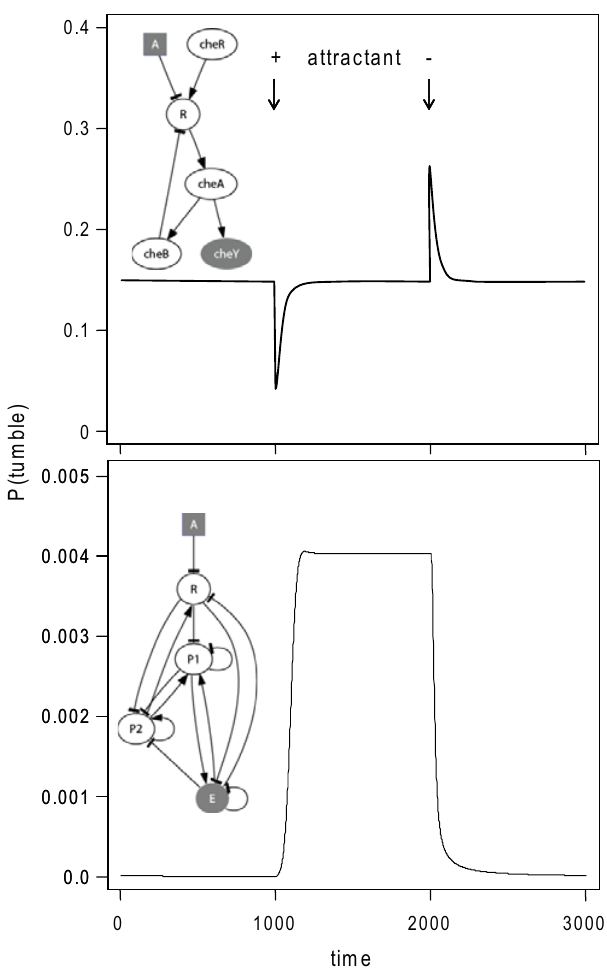
Figure 2. Adaptive versus non-adaptive pathway dynamics. Time course of phosphorylated CheY concentration (top), as simulated by the model presented in [10] and the time course of active effector concentration for the most frequent pathway in the evolutionary simulation described in Figure 1 (bottom). The inset shows the cartoon representation of this pathway. In both simulations, the system is allowed to pre-equilibrate for 1,000 timesteps. A stimulus of one is then added at time 1,000 and removed at time 2000. Kinetic parameters for the shown pathway are given in Dataset S1.